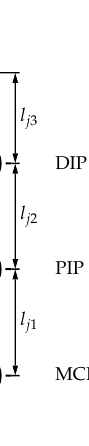
Figure 2. Open kinematic chain of finger II to V ( j = { } 2,3,4,5 ) with the Metacarpophalangeal (MCP), Proximal Interphalangeal (PIP) and Distal Interphalangeal (DIP) joints. For better distinction, the x ji axes of the local coordinates K ji of each joint are red and the z ji axes are blue. The distances l ji correspond to the functional lengths of phalanges of the fingers.